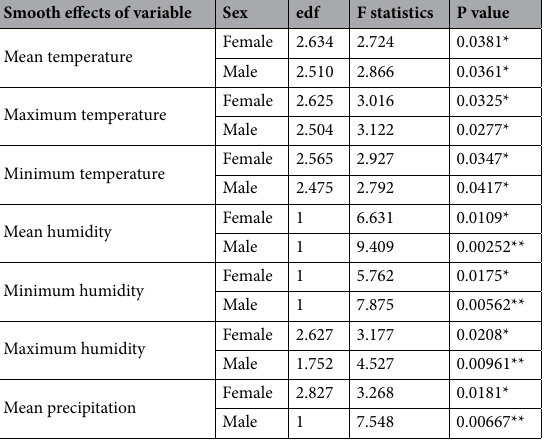
Table 3. Results of a GAM model, with the effective degrees of freedom (edf), F statistics , and P value using non-parametric